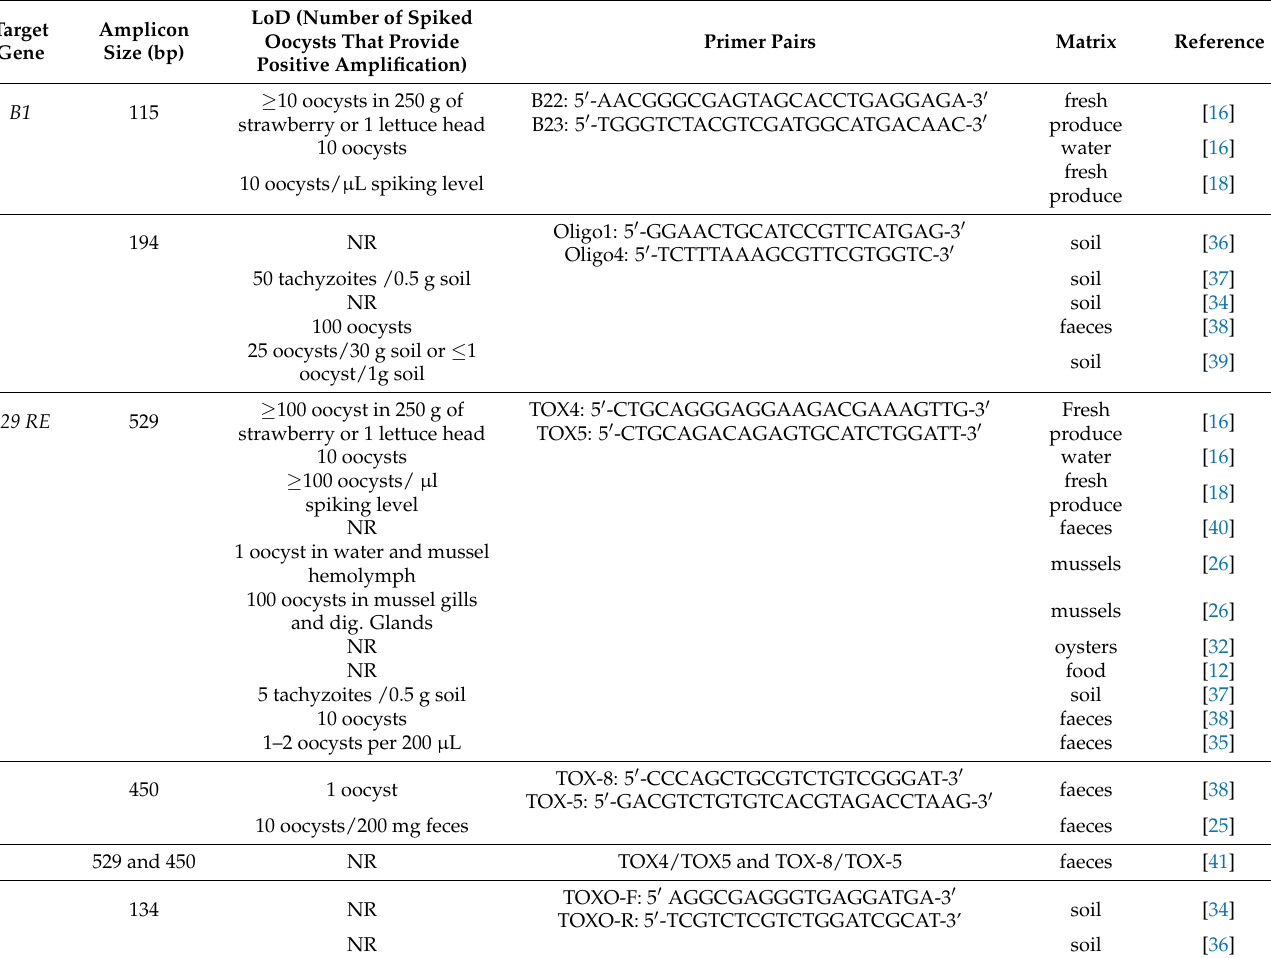
Table 4. Conventional PCR assays targeting B1 gene and 529 RE used for Toxoplasma gondii oocysts detection. Target Amplicon Gene Size